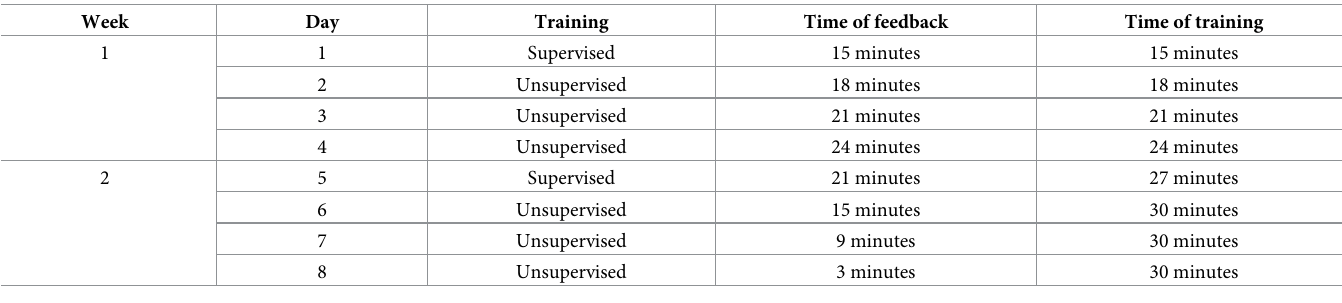
Table 1. Protocol performed in groups A and